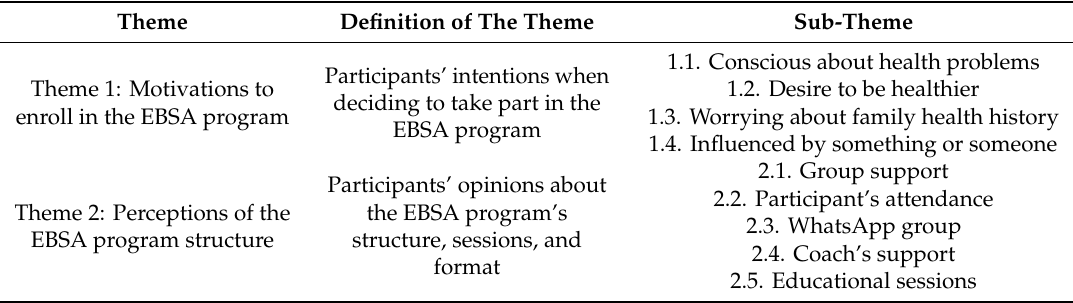
Table 2. Themes developed from the focus